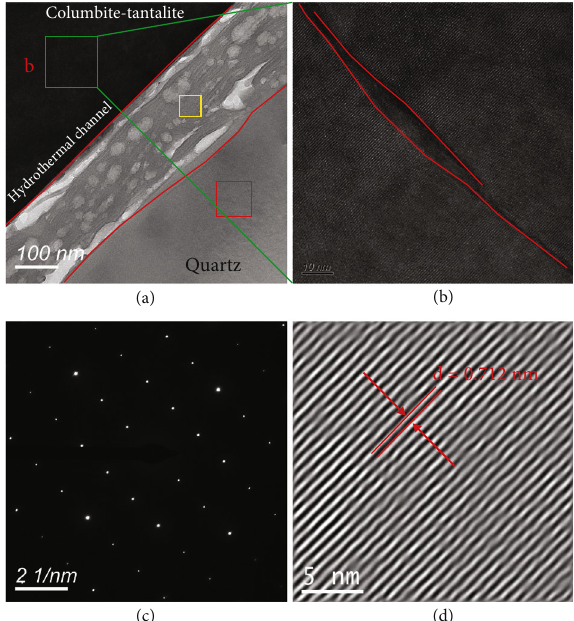
Figure 6: (a) Focused ion beam-cut of the columbite-tantalite mineral. (b) High-magni fi cation transmission electron microscopy image obtained from the green square in (a). (c) Selected area electron di ff raction pattern obtained from the green square in (a). (d) High- resolution transmission electron microscopy image obtained from the green square in